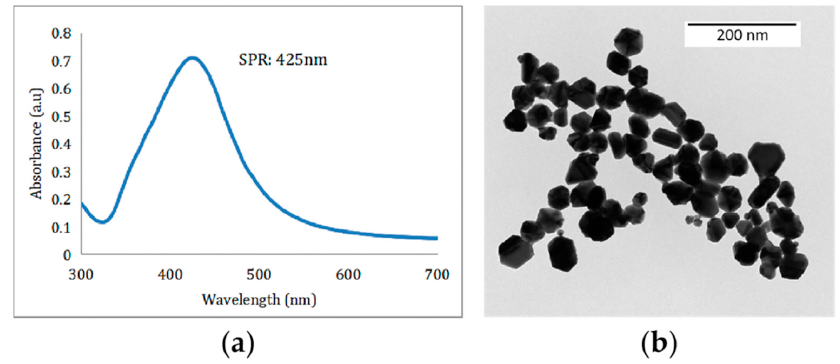
Figure 7. ( a ) UV ‒ Vis spectra of sodium citrate-reduced AgNPs, ( b ) TEM image of the sodium citrate- reduced AgNPs.